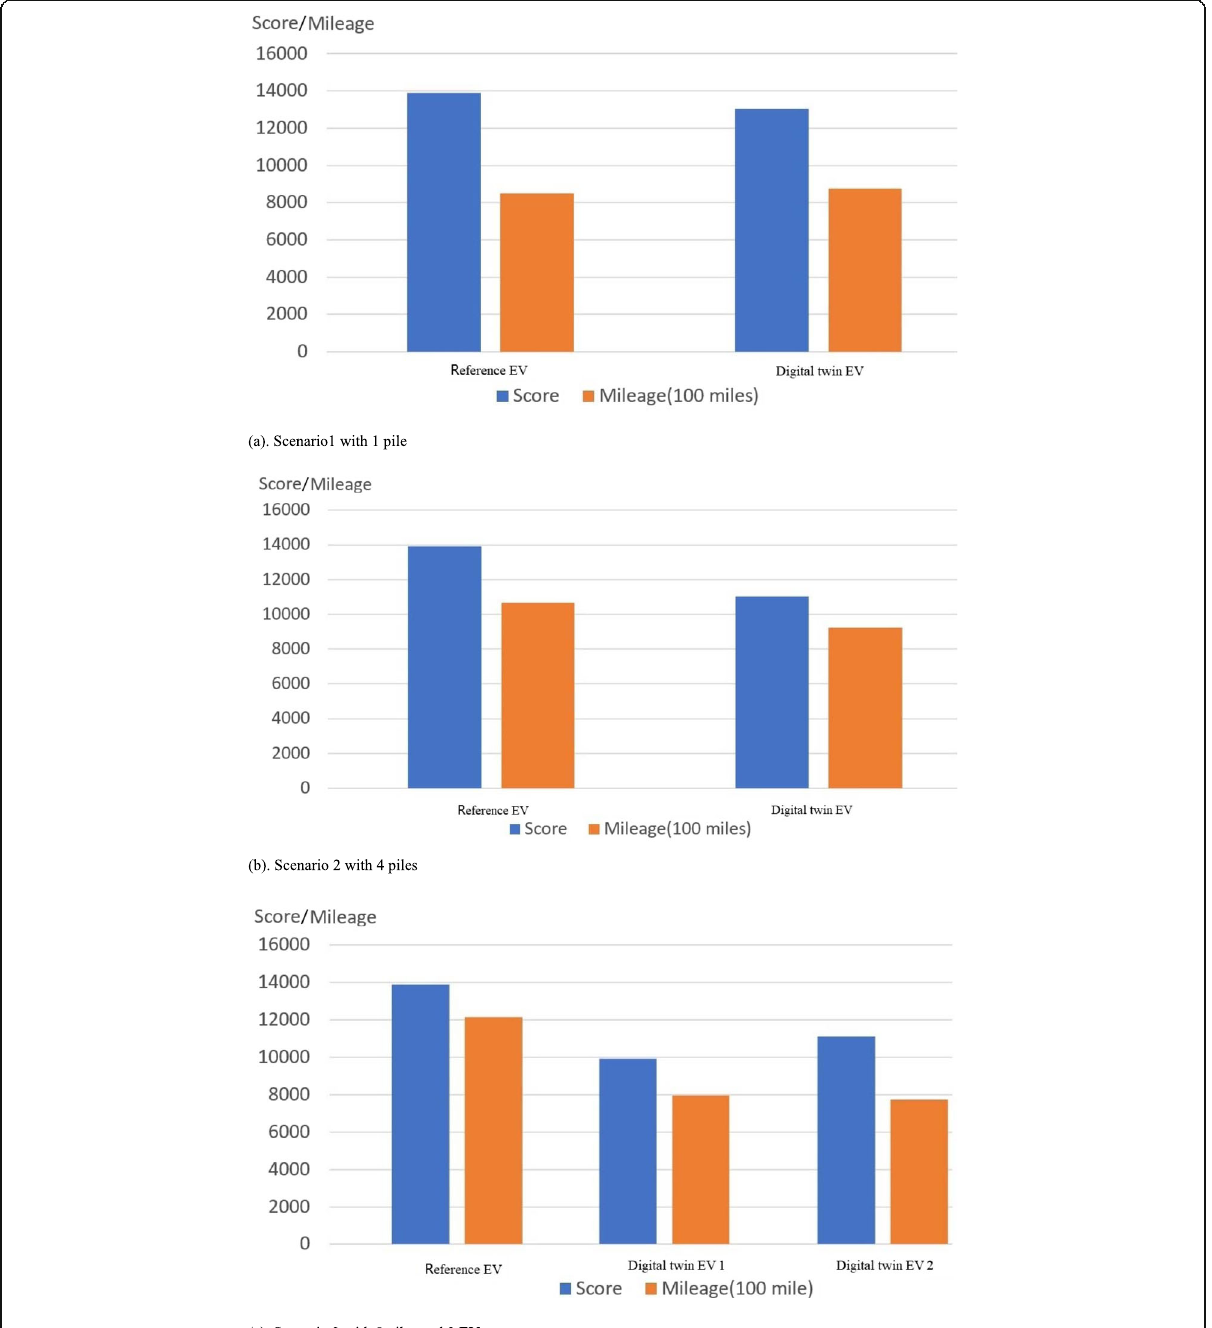
Fig. 4 Score and mileage of reference EV and digital EVs in 3 scenarios. a Scenario1 with 1 pile. b Scenario 2 with 4 piles. c Scenario 3 with 8 piles and 3